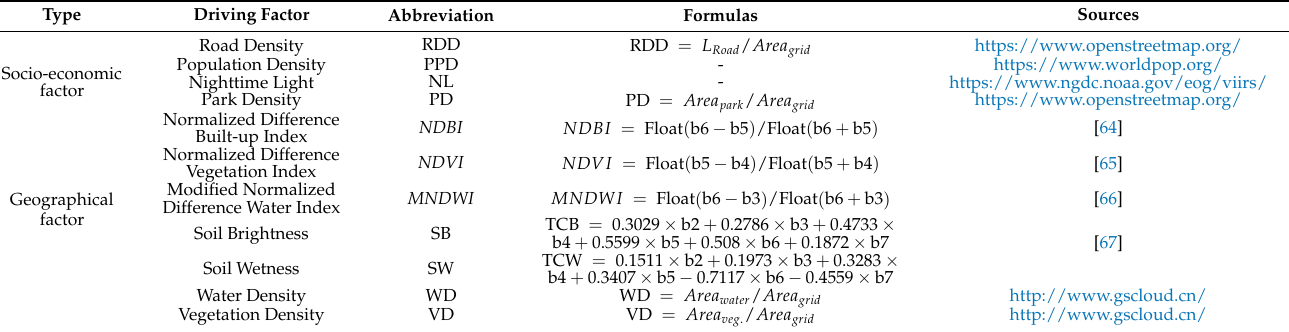
Table 1. Drivers of land surface